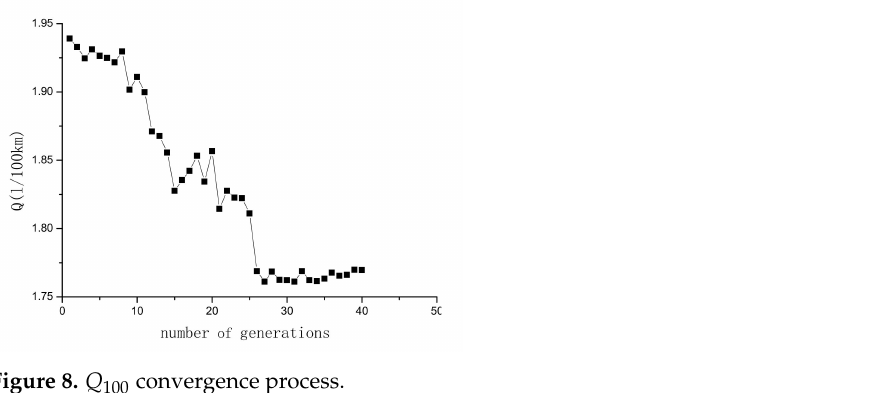
Figure 8. Q 100 convergence process. The C hess convergence process is as in Figure 9, basically stable after near 30 generations.